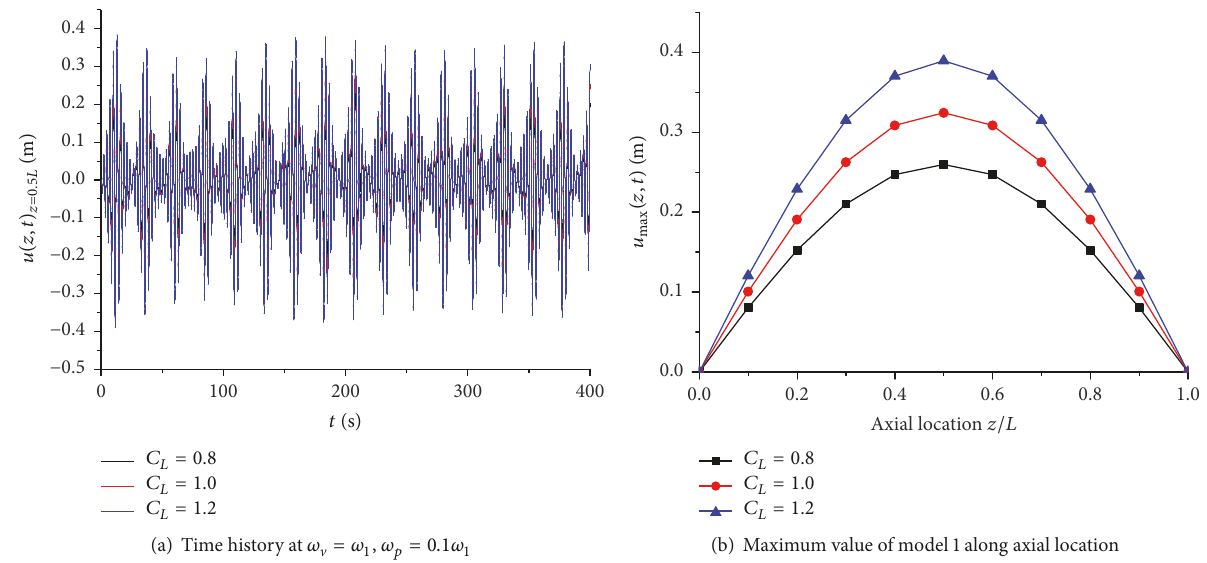
Figure 13: The effect of lift coefficient on the dynamic response of the